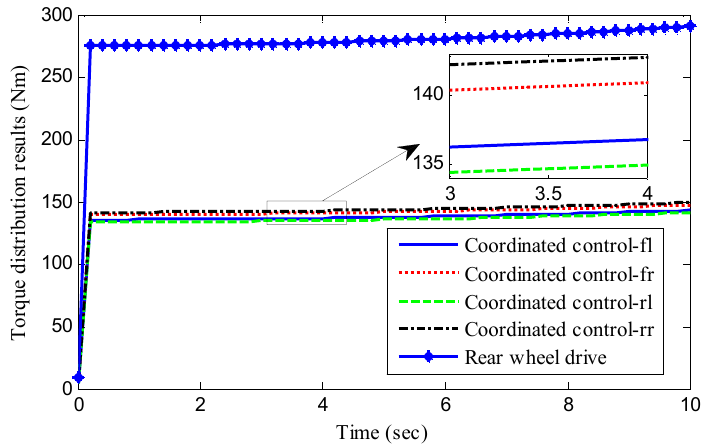
Figure 15. Torque distribution results in case study 2.